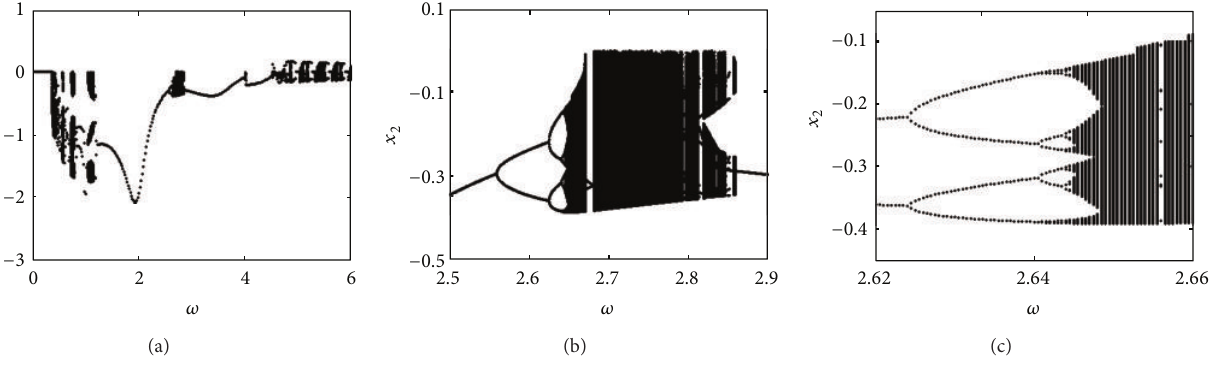
Figure 2: Bifurcation diagram of the system.